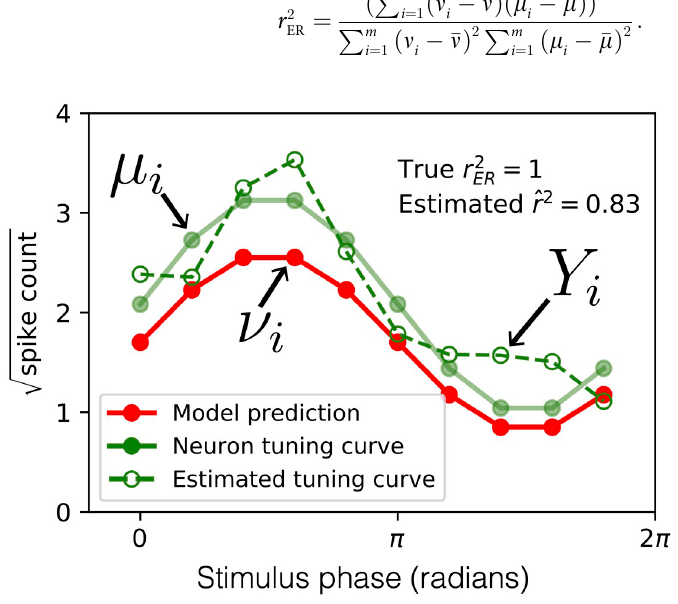
Fig 1. Sampling noise confounds estimation of the correlation between model prediction and neuronal tuning curve. The expected (true) spike counts in response to a set of 10 stimuli (solid green points) is perfectly correlated with a model (red points), yet owing to sampling error (neural trial-to-trial variability) the estimated tuning curve (green open circles) has correlation less than one with the model ( ^ r 2 ¼ 0 : 83 ).